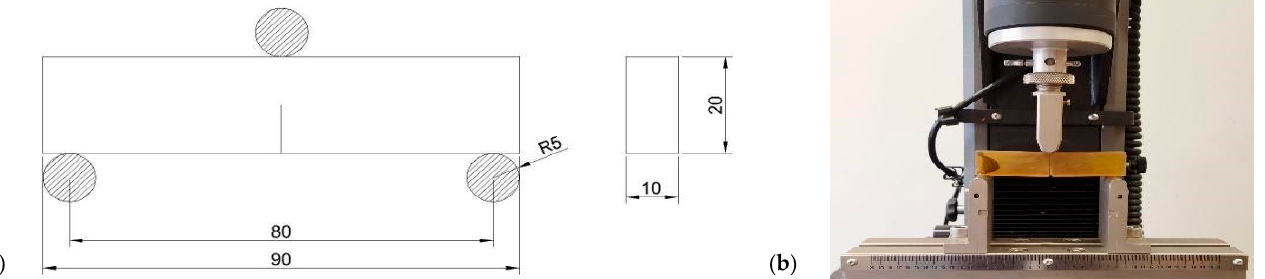
Figure 2. ( a ) Dimensions of the fracture toughness test sample (in mm). ( b ) Fracture toughness tests performed on the testing machine, 3 ‐ point bending test.